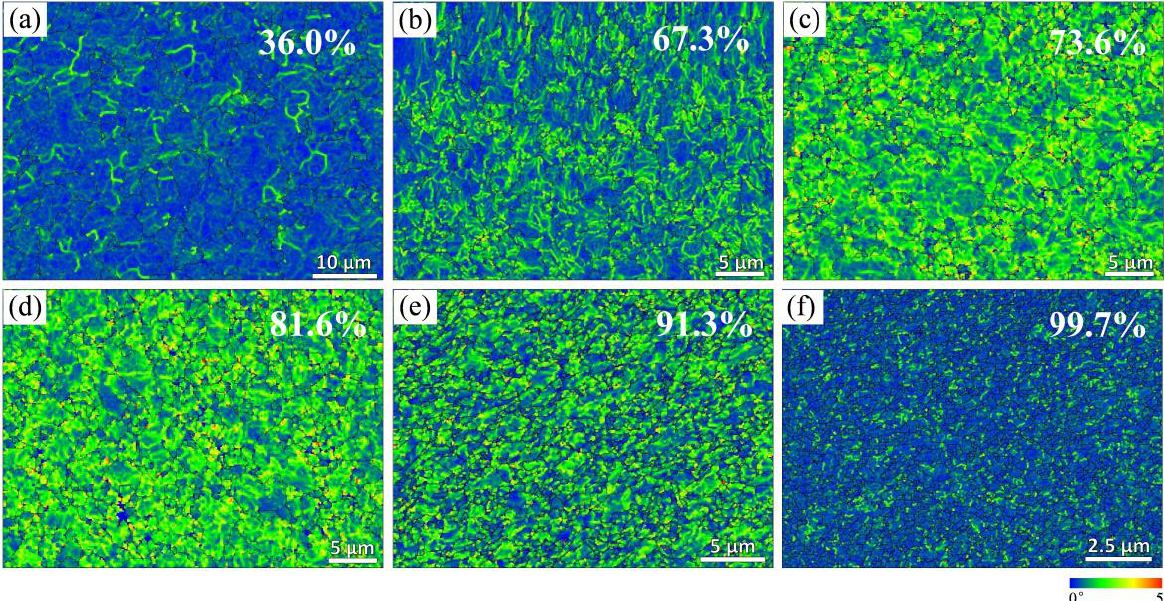
Figure 10. KAM maps of the as-drawn composites with different drawing reductions: ( a ) 36.0%, ( b ) 67.3%, ( c ) 73.6%, ( d ) 81.6%, ( e ) 91.3%, and ( f ) 99.7%.